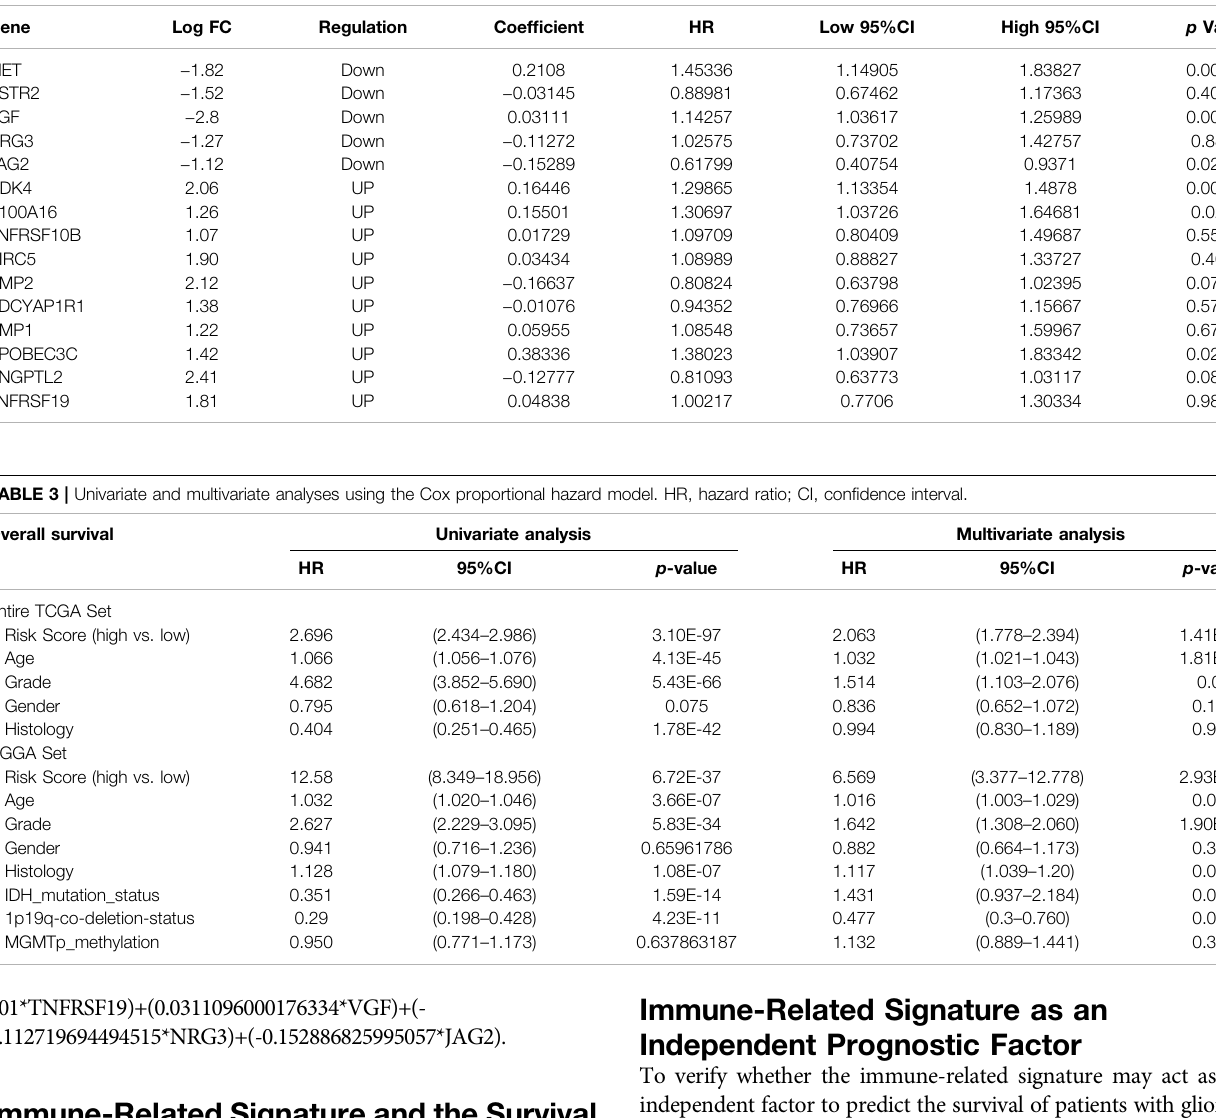
TABLE 2 | Coef fi cients and multivariable Cox model results of 15 genes in the immune-related signature. Gene Log FC